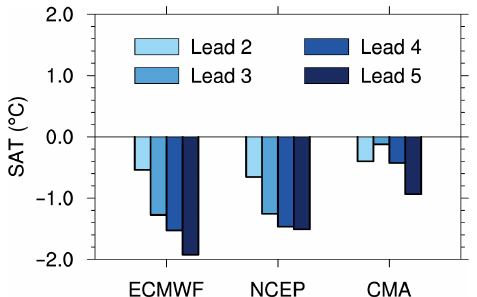
Figure 8. Differences in the multiyear wintertime mean surface air temperature over the Tibetan Plateau (unit: ◦ C) between forecasts with a lead of 2–5 weeks and forecasts with a lead of 1 week in each